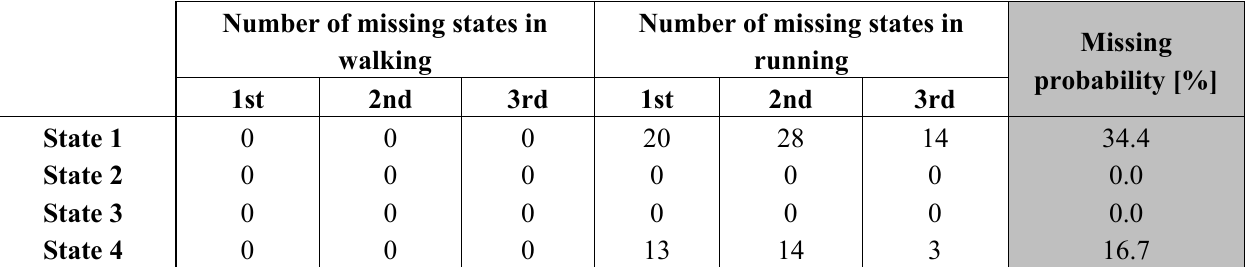
Table 1. Missing states during walking and running (30 steps test for each trial). Number of missing states